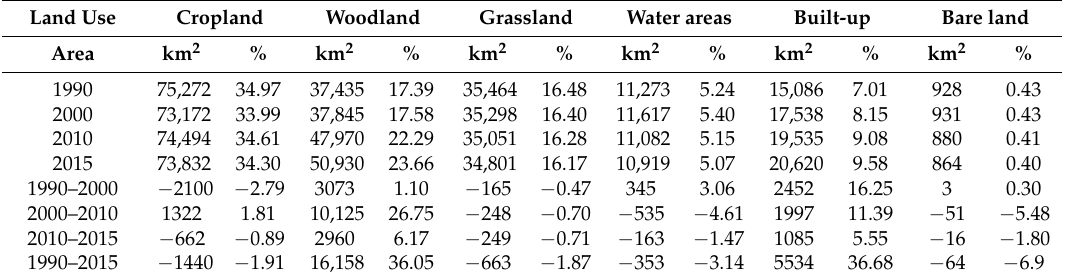
Table A2. Areal changes in land use from 1990 to 2015 in the Jing-Jin-Ji region.